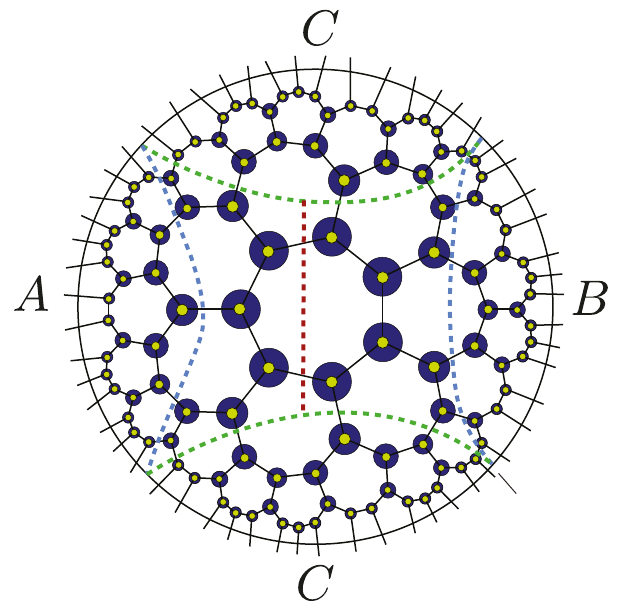
Figure 3 . A random stabilizer tensor network with subregion AB in the connected phase. The green dotted line represents the RT surface for subregion AB , while the yellow dotted lines represent the RT surface of A and B respectively. The red dotted line represents EW ( A : B